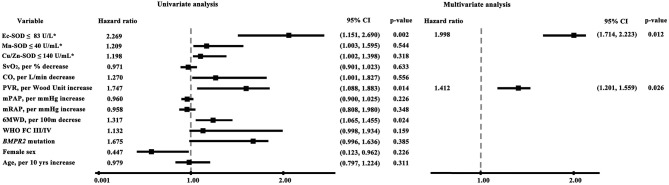
Cox proportional hazards model of factors associated with survival in idiopathic pulmonary arterial hypertension (univariate and multivariate analyses). The lower Ec-SOD and the higher PVR remained as significant predictors of adverse outcomes. The asterisk indicates identification by the receiver operating characteristic analysis curve-derived cutoff value. BMPR 2, bone morphogenetic protein receptor type 2; CO, cardiac output; Cu/Zn-SOD, copper–zinc superoxide dismutase; Ec-SOD, extracellular form of Cu/Zn superoxide dismutase; Mn-SOD, manganese superoxide dismutase; mPAP, mean pulmonary arterial pressure; mRAP, mean right atrial pressure; 6MWD, 6-min walking distance; PVR, pulmonary vascular resistance; SvO2, mixed venous oxygen saturation.